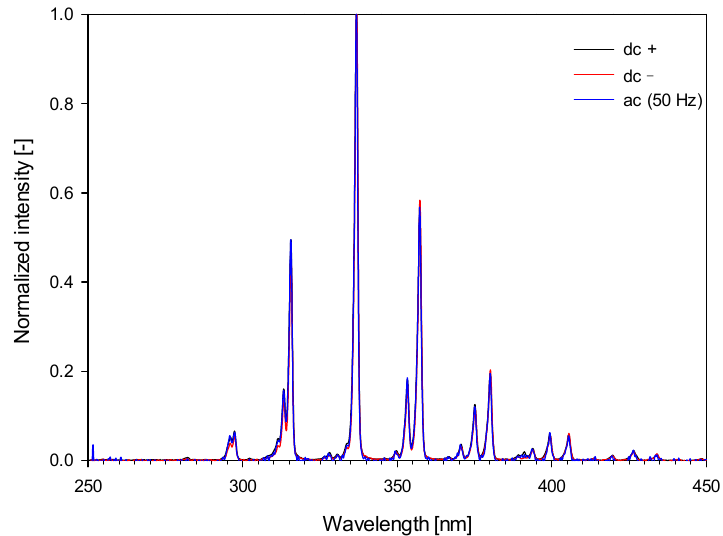
Figure 3. Normalized spectra of the corona discharges with positive and negative dc supply, and 50 Hz ac supply using a needle-plane gap (diameter = 3.5 mm, gap = 150 mm).